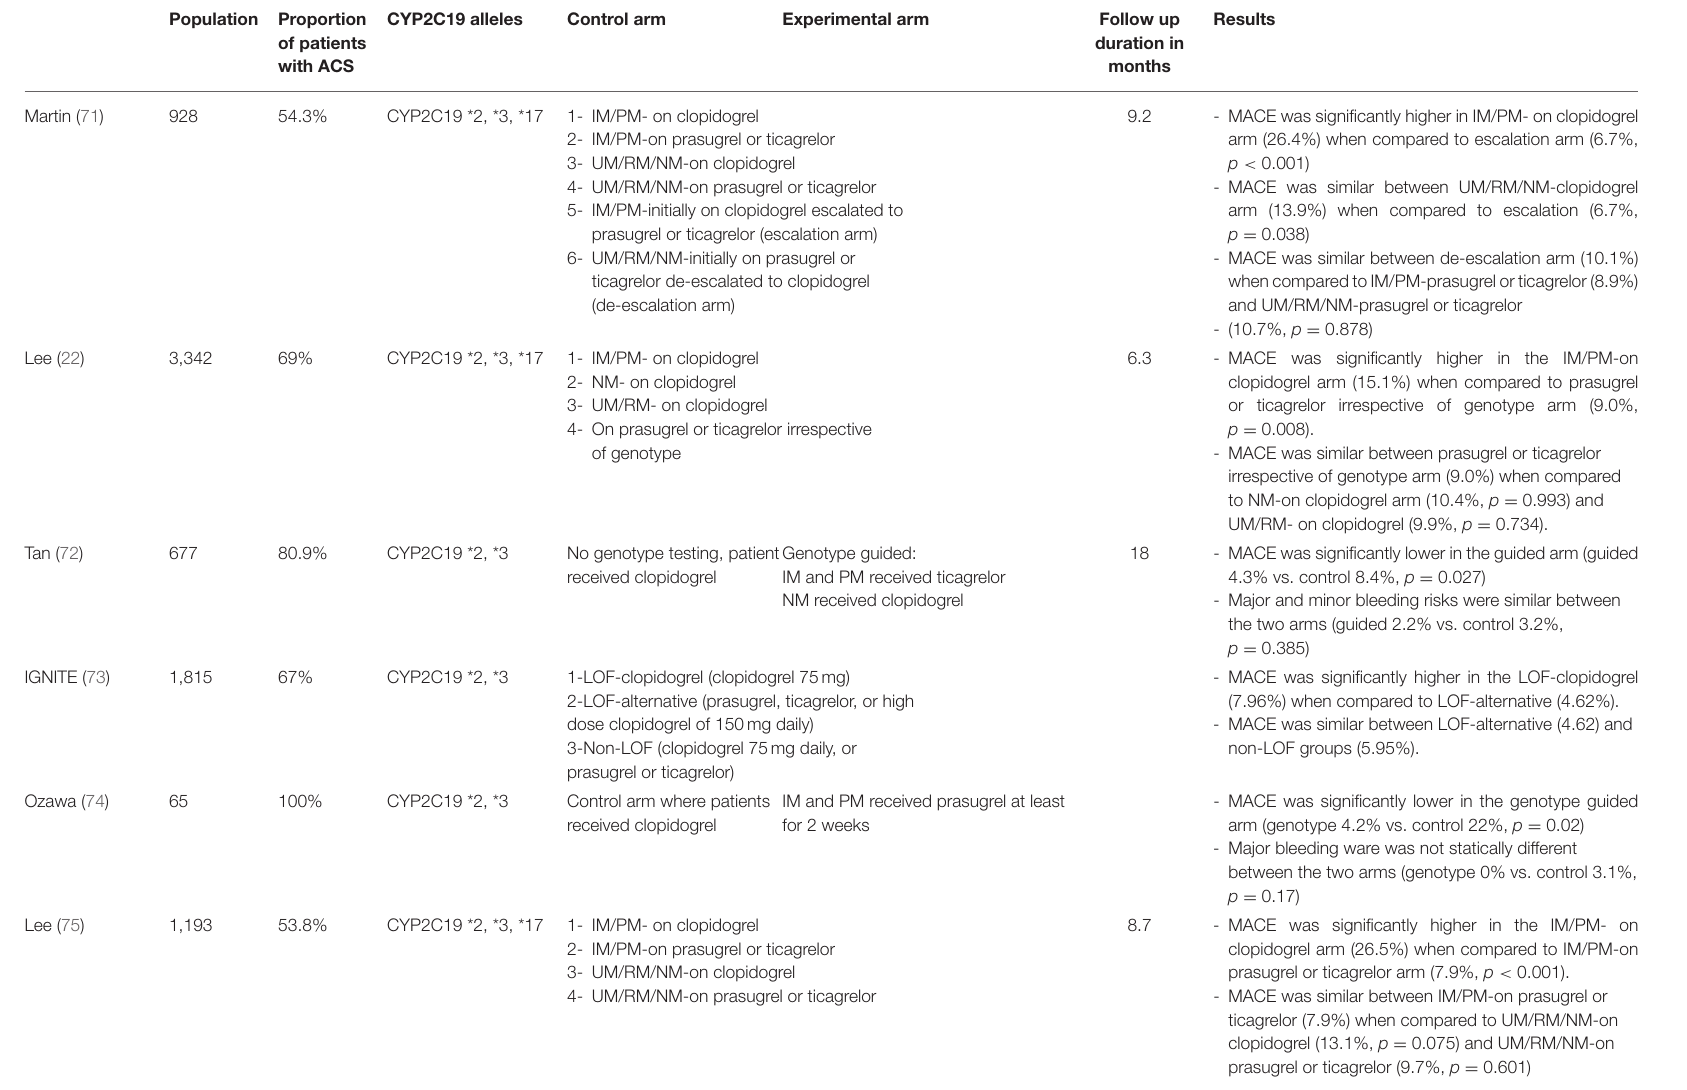
- MACE was significantly higher in IM/PM- on clopidogrel arm (26.4%) when compared to escalation arm (6.7%,